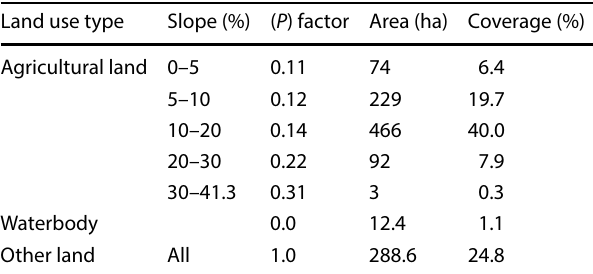
Table 6 Land use, slopes, and P -factor values Land use type